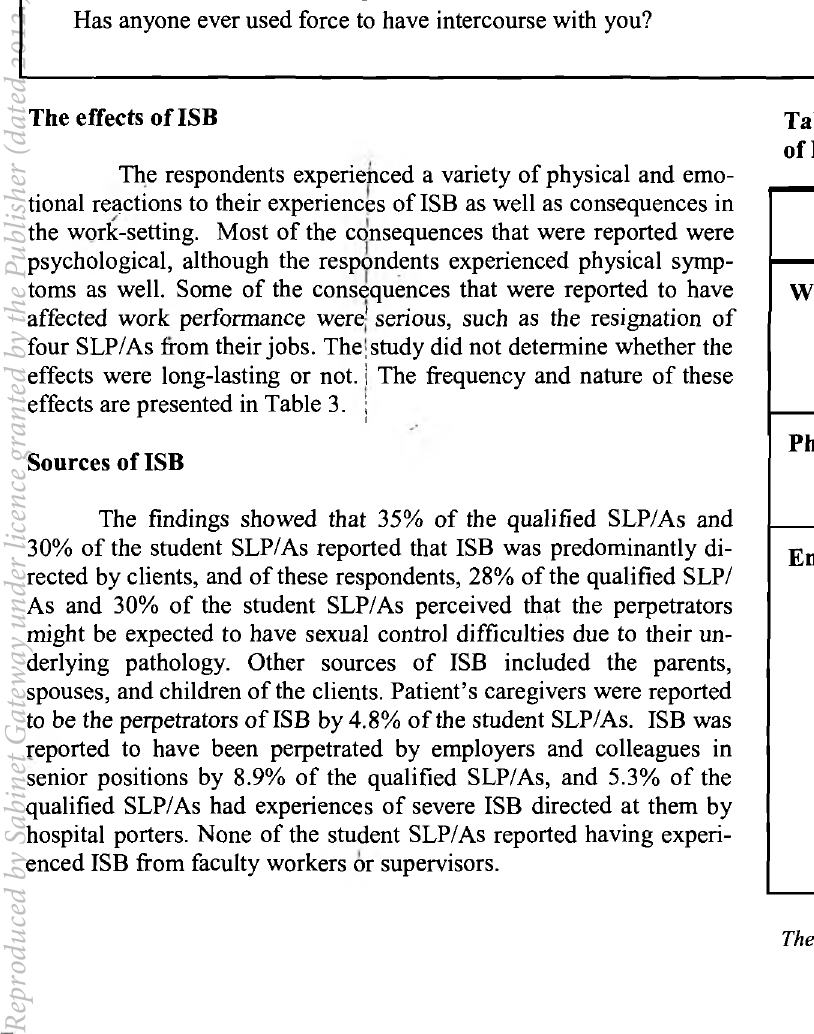
Table 3: Respondents Reported Effects of the